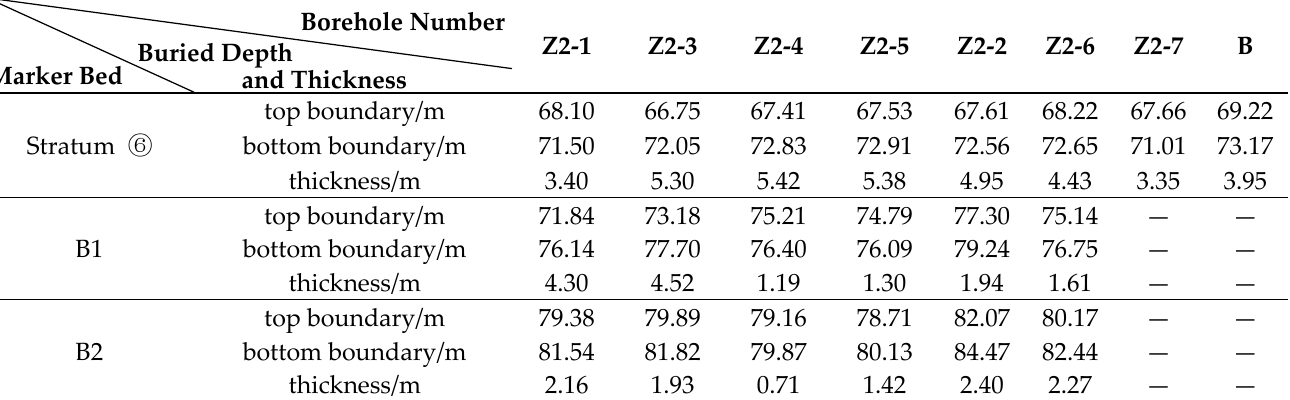
Table 4. The buried depth and thickness of Stratum ⑥ and marker beds revealed by composite drilling section in Lizui Village.